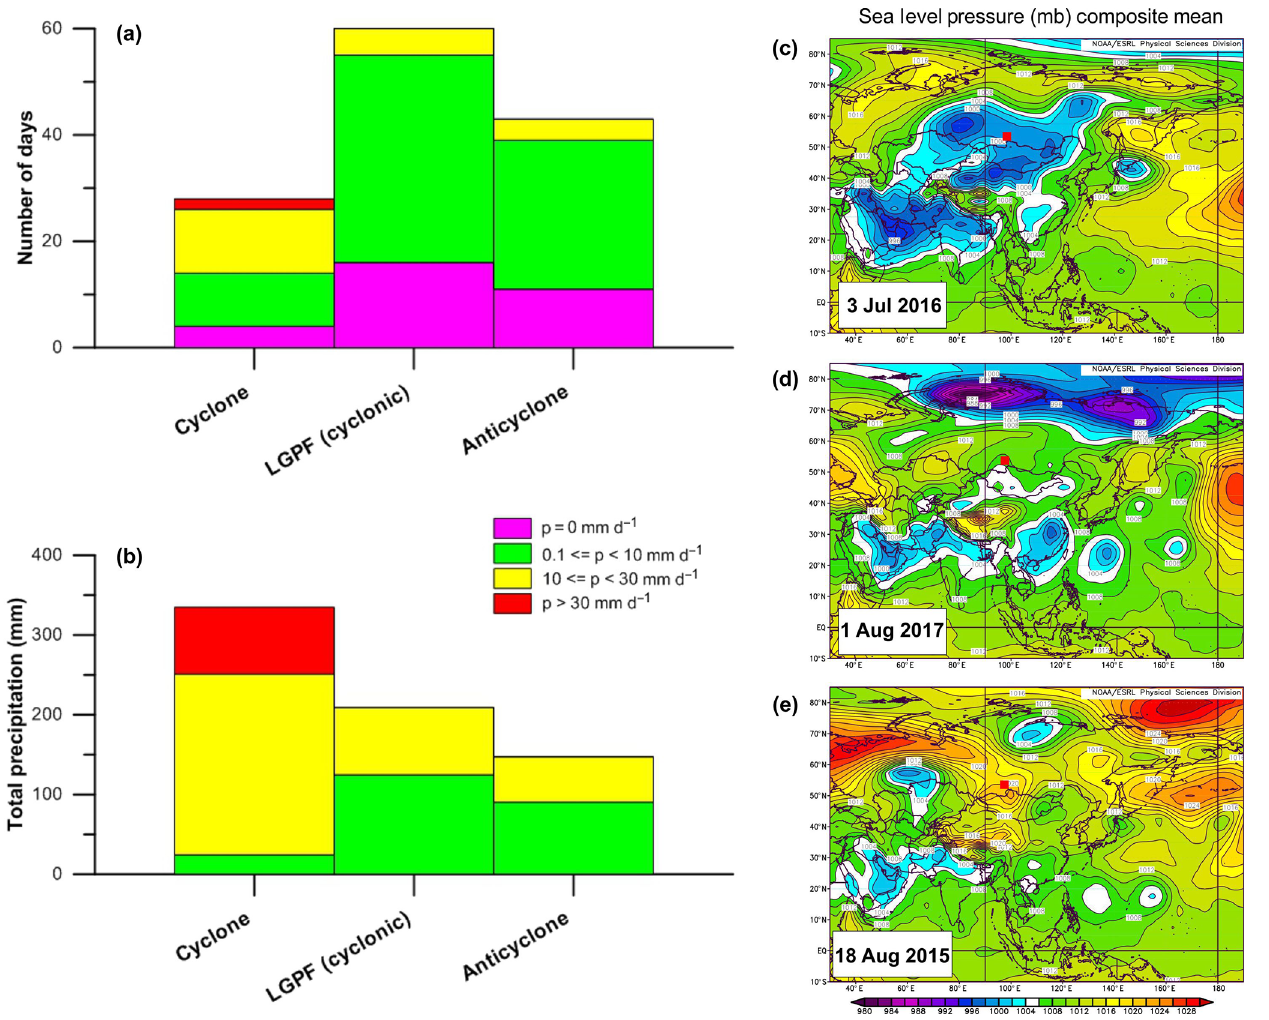
Figure 4. Relationship between types of baric field over the East Sayan and the number of precipitation days (a) and total precipitation (b) on the glacier. Typical sea level pressure maps for cyclonic (c) , low-gradient cyclonic (d) , and anticyclonic (e) fields. LGPF means low gradient pressure